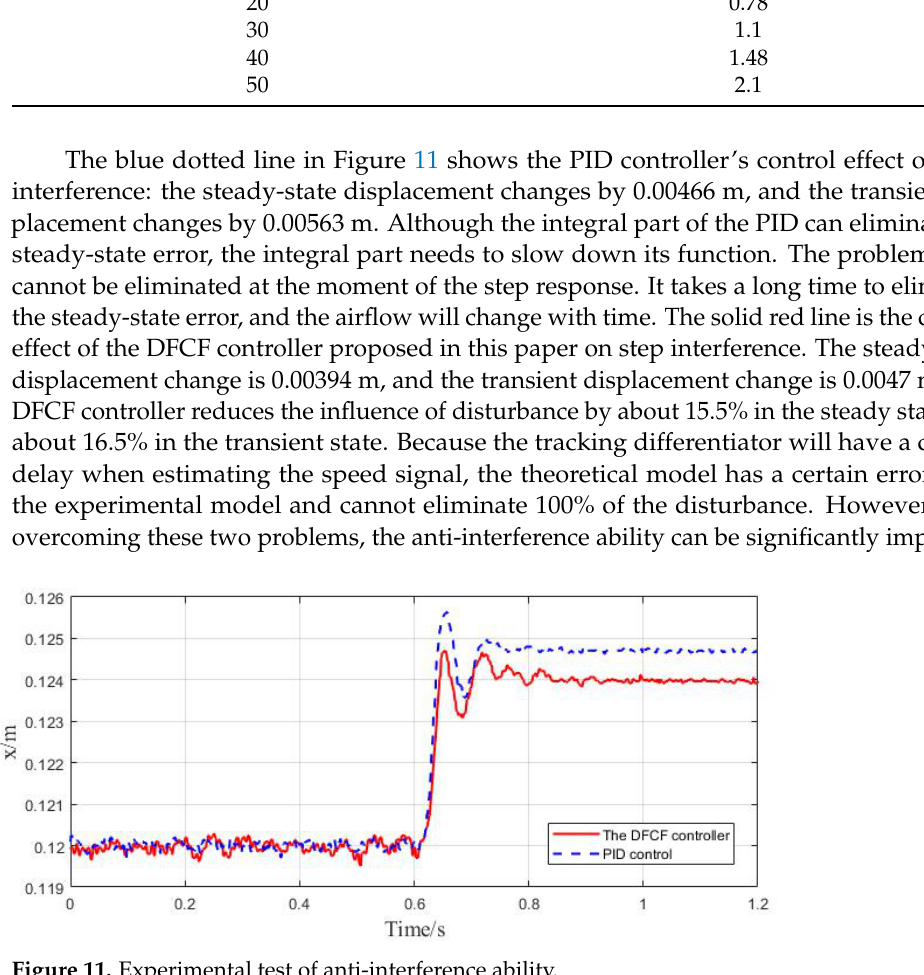
Figure 11. Experimental test of anti-interference